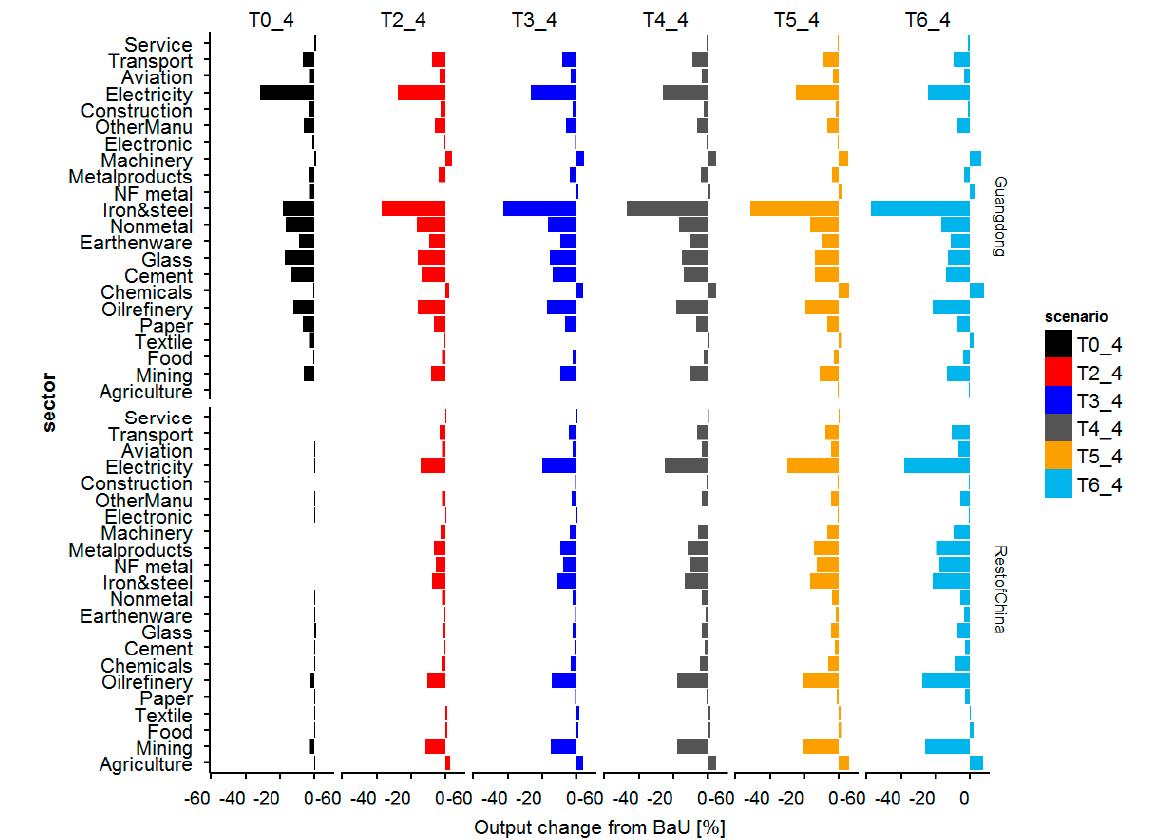
Figure 4. Impact on sectoral output in 2030.